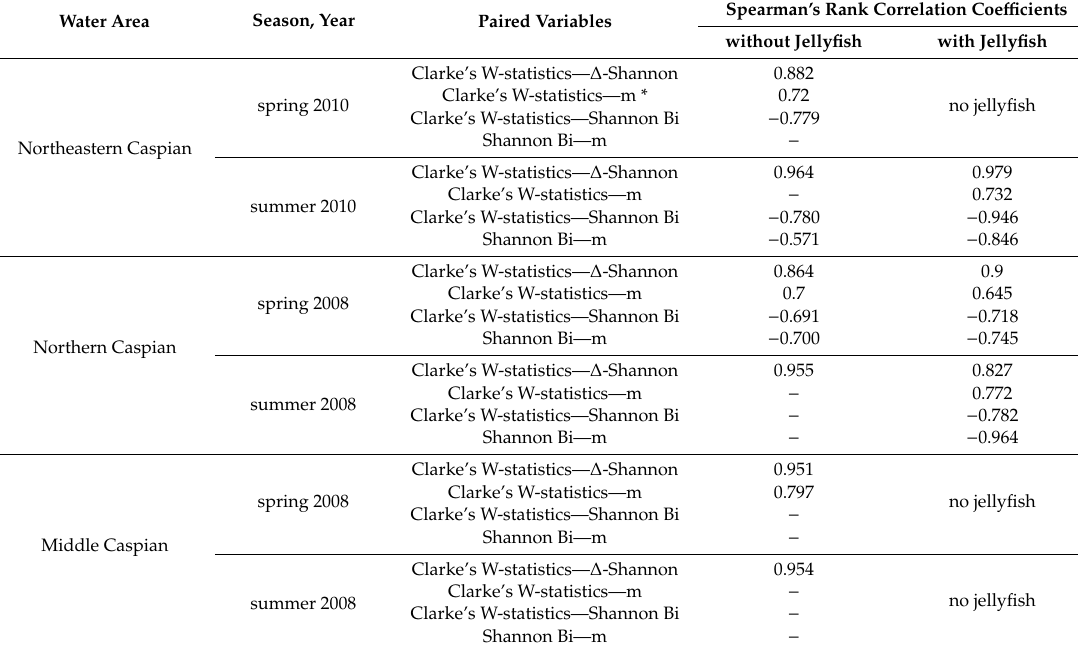
Table 8. Spearman’s rank correlation coe ffi cients between structural variables of zooplankton communities in the surveyed water area of the Caspian Sea, p <